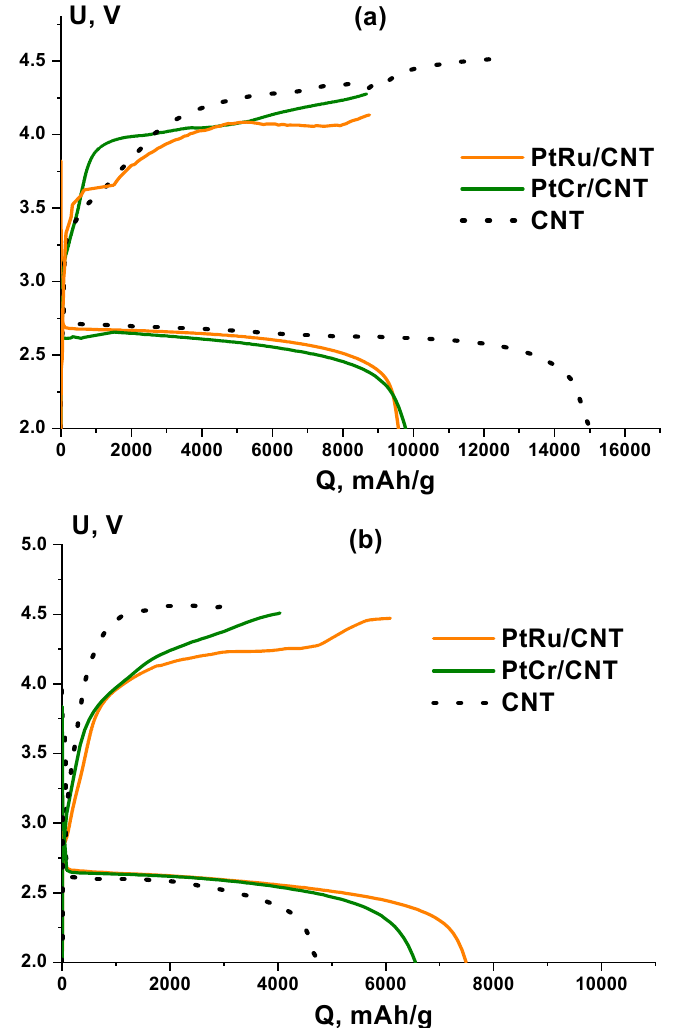
Figure 1. Discharge-charge curves of LOB obtained in an atmosphere of pure oxygen at current densities of 200 mA/g ( a ) and 500 mA/g ( b ) using various materials in the positive electrode. 1M LiClO 4 /TEGDME.